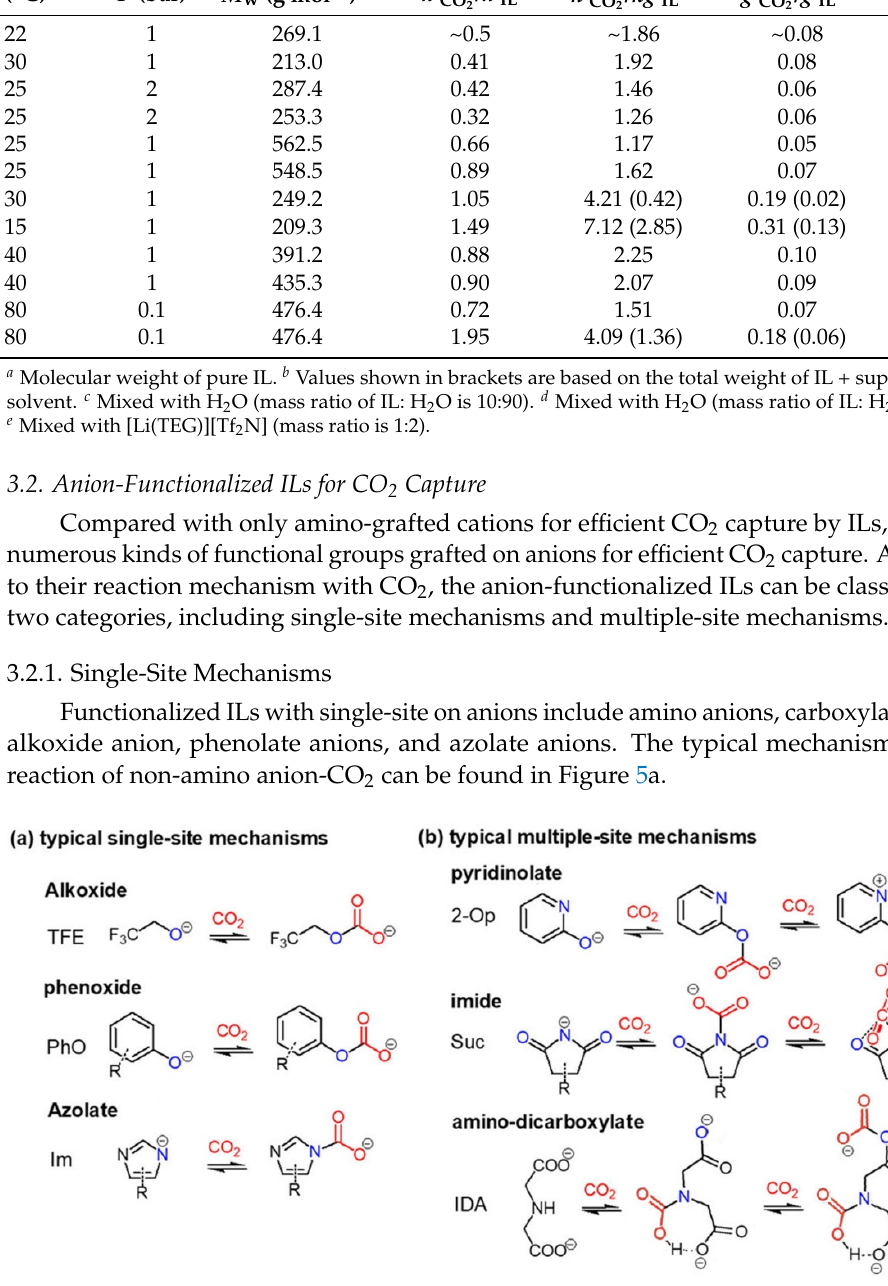
Figure 5. Typical ( a ) single-site and ( b ) multiple-site mechanisms of non-amino anion-CO 2 reactions. (1) Amino anion functionalized